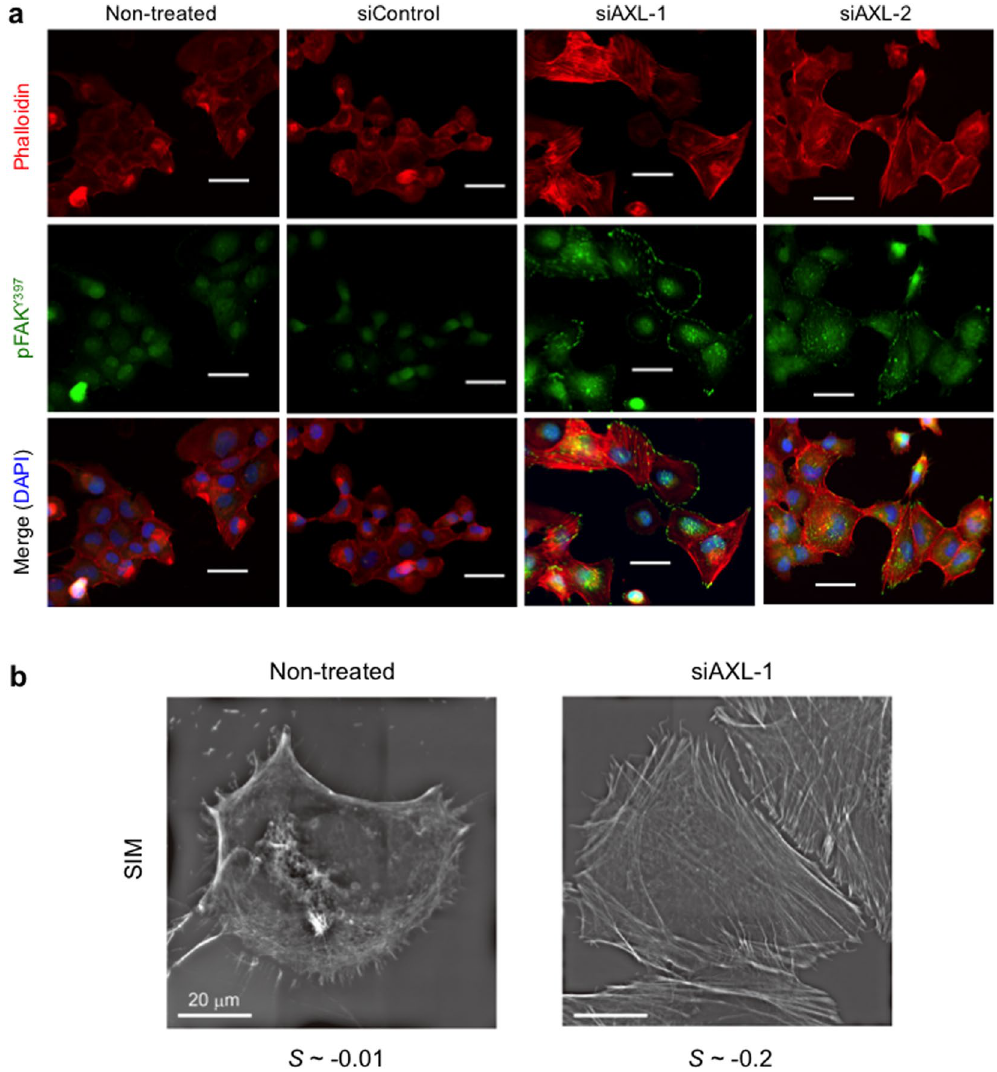
stress fibres in high resolution in non-treated and siAXL-1-transfected H1299 cells by structures illumination microscopy (SIM). Order parameters of actin stress fibres ( S ) are calculated from each SIM image as shown in Supplementary Information. Similar results were obtained in three independent